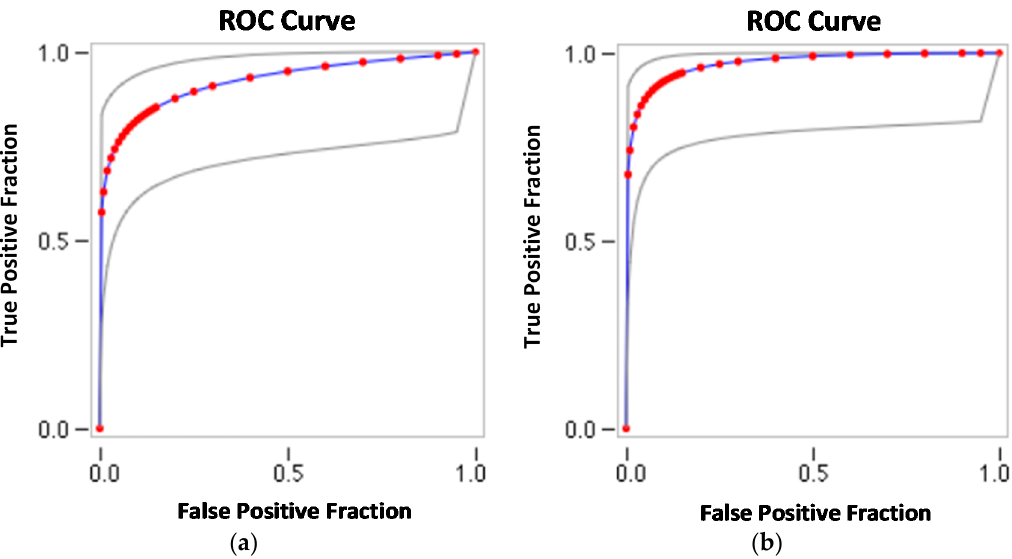
Figure 22. Receiver Operating Characteristic (ROC) curves for the ( a ) coherence difference and ( b ) normalized coherence difference maps – Sentinel–1B average.